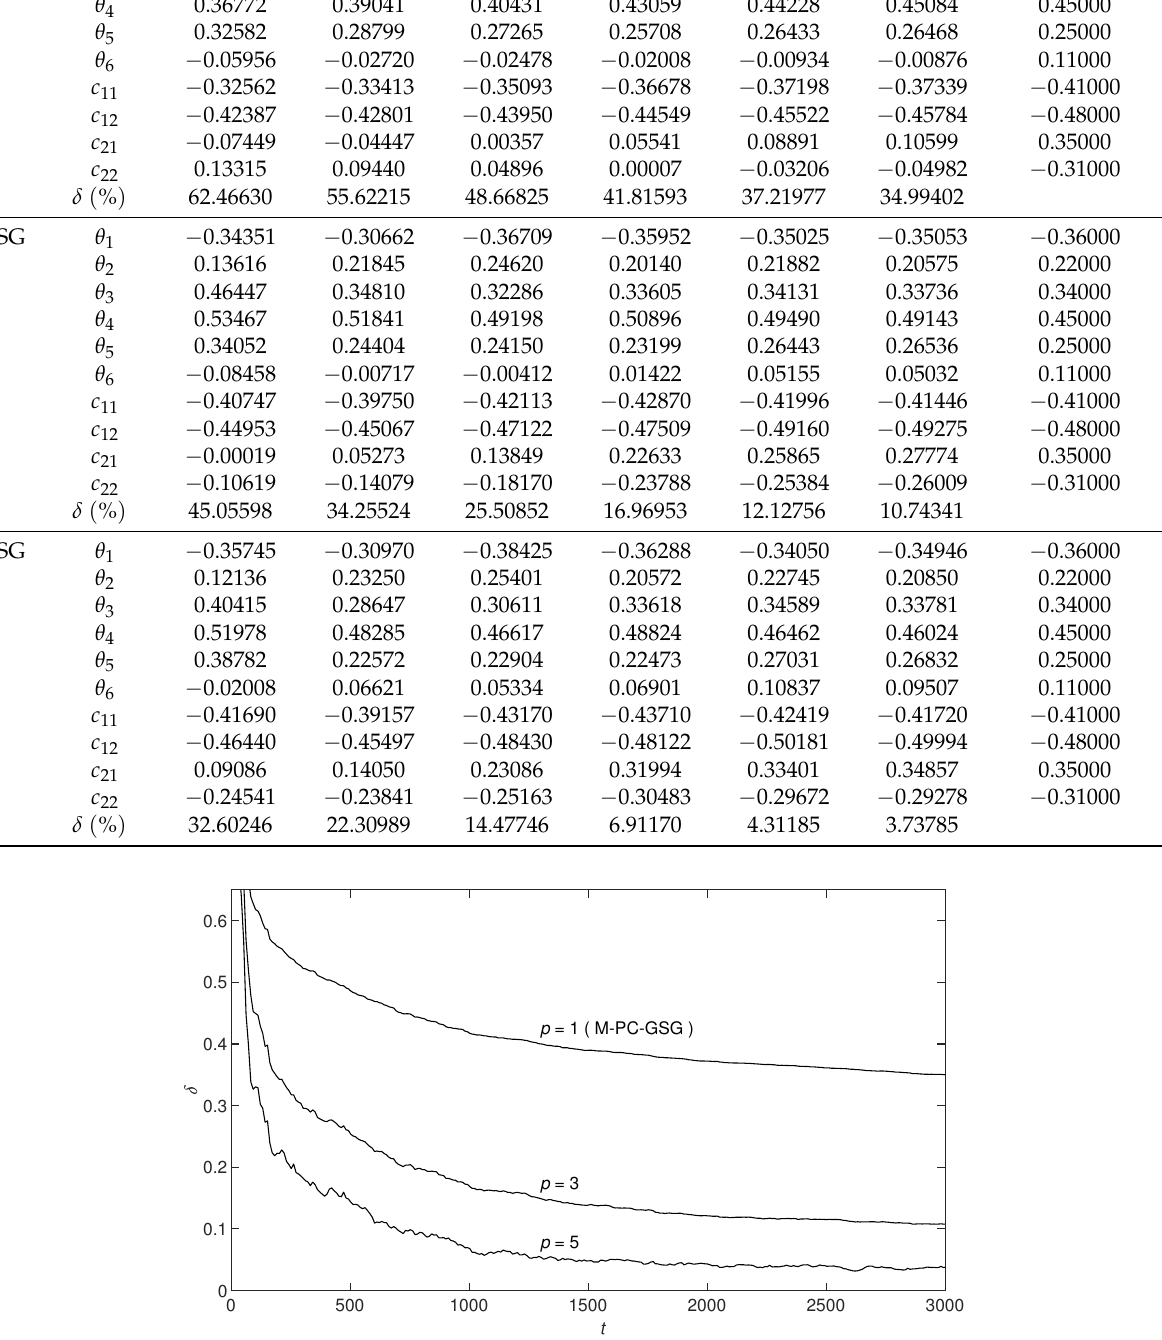
Figure 5. The M-PC-MI-GSG estimation errors versus t